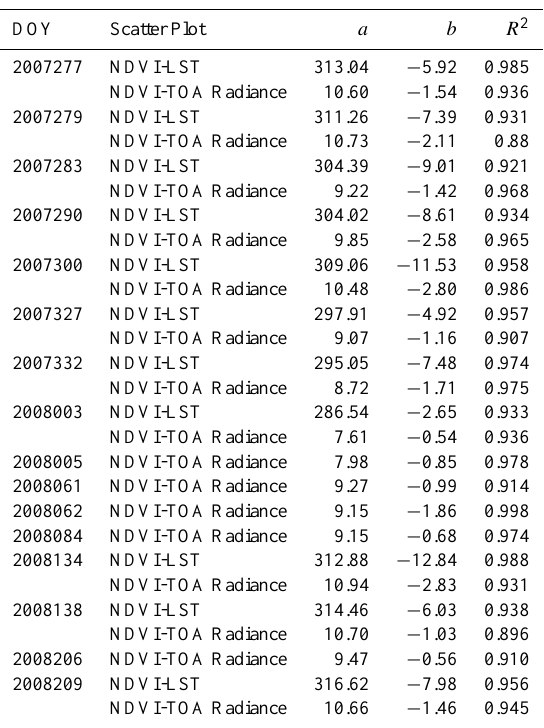
Table 3. Statistics of the dry edge values used for estimation of EF ( a and b represent the intercept and slope of the dry edge respec-